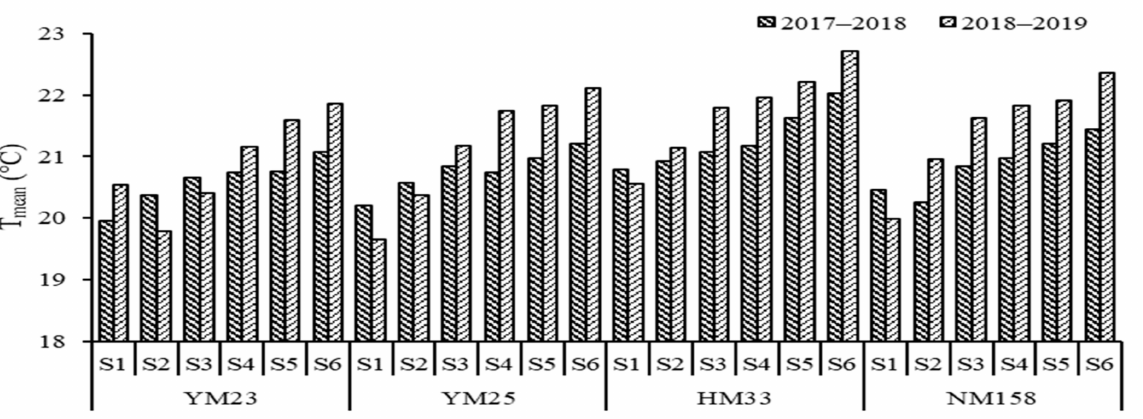
Figure 5. Change in daily mean temperature (T mean ) after anthesis on different sowing